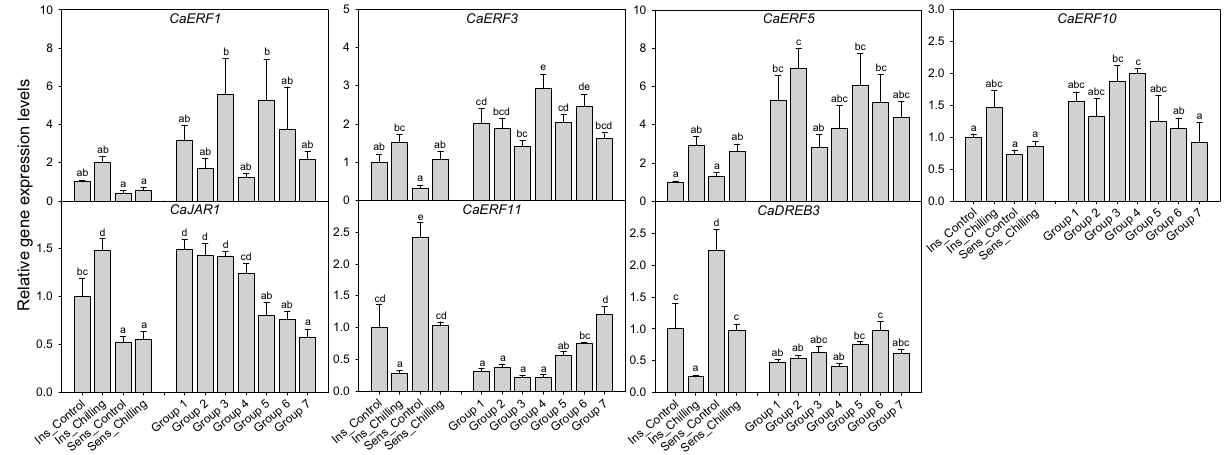
Figure 4. Relative expression levels of CaJAR1 and CaERF family genes in ‘ UZB-GJG-1999–51 ’, ‘ C00562 ’, and F 2 groups after chilling treatment at 2 °C for 3 weeks. Ins, chilling-insensitive ‘ UZB-GJG-1999–51 ’ pepper; Sens, chilling-sensitive ‘ C00562 ’ pepper. The groups were designated as Group 1 through Group 7, with seed browning rates being 0–10%, 10–20%, 20–30%, 30–40%, 40–50%, 50–60%, and > 60%, respectively. Vertical bars are means ± SE. Different letters represent significant differences ( p < 0.05) in Duncan’s multiple range